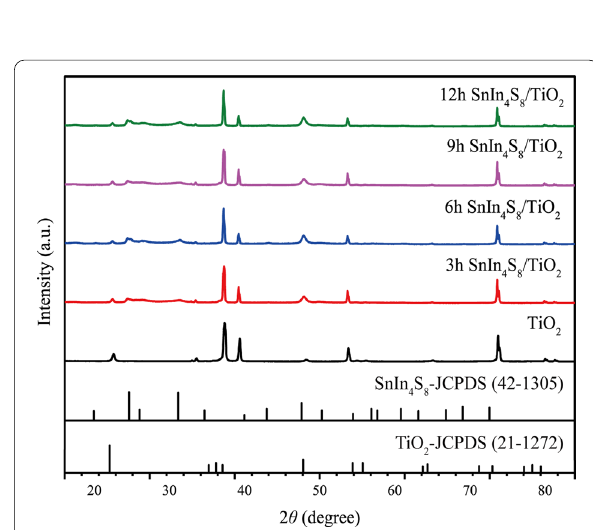
Fig. 3 XRD spectra of pure TiO 2 and the different SnIn 4 S 8 /TiO 2